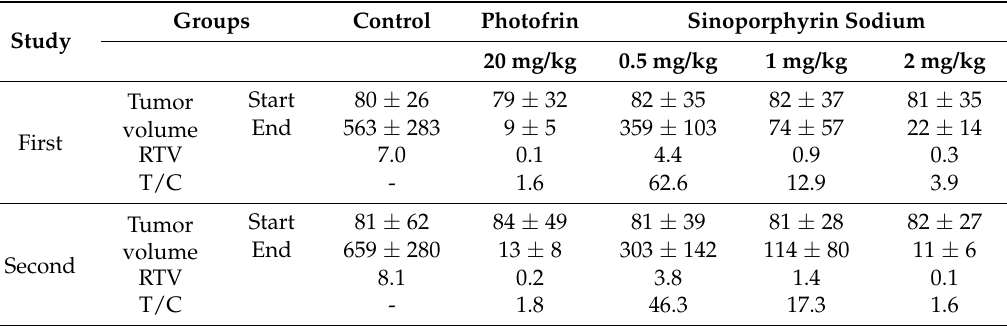
Table 4. Tumor volumes, RTV and T/C values in hepatoma HepG2 xenograft